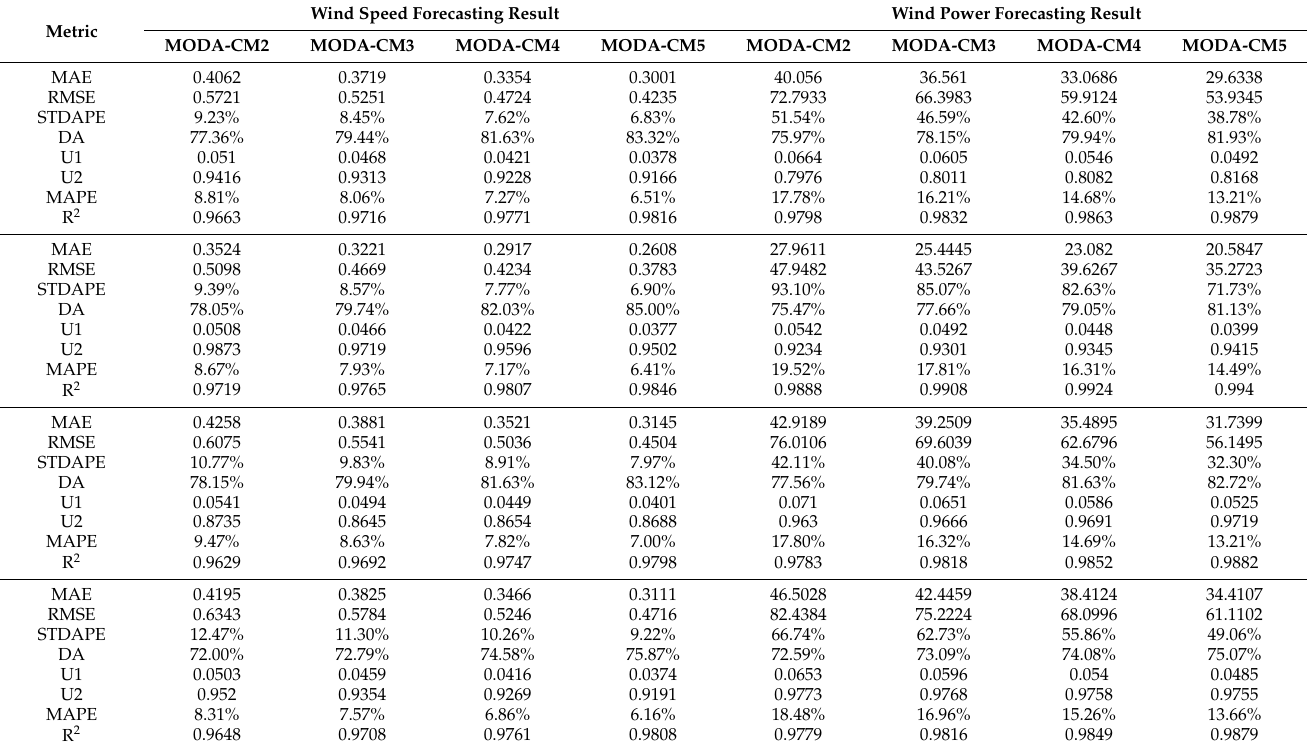
Table 4. Wind speed forecasting results for each site by different models for the first